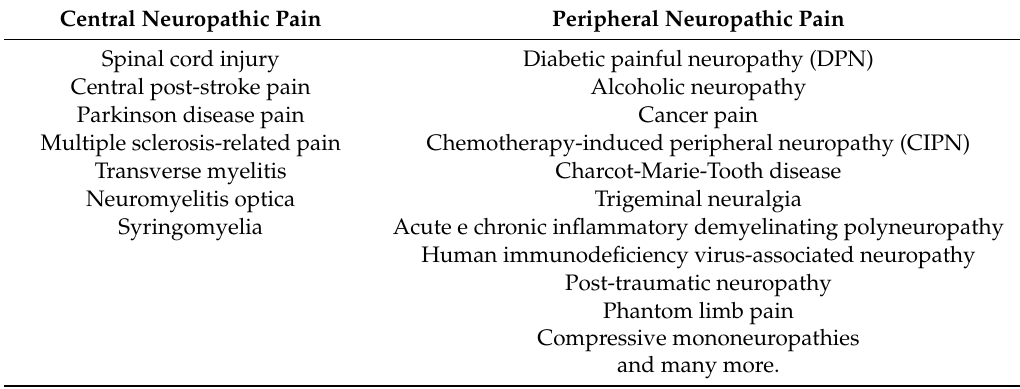
Table 1. The more common neuropathic pain.